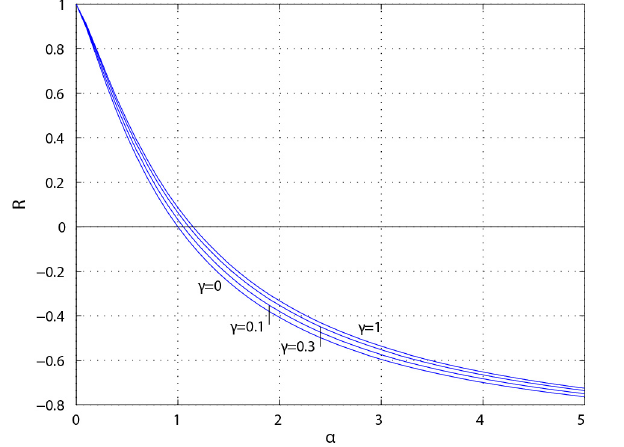
Figure 5. Reflection coefficient (R) plotted as a function of the ratio (α) of daughter-vessel total cross-sectional area to mother- vessel cross-sectional area. The symmetry ratio is given by γ where γ = 0 corresponds to a straight tube with no bifurcations [ 4]